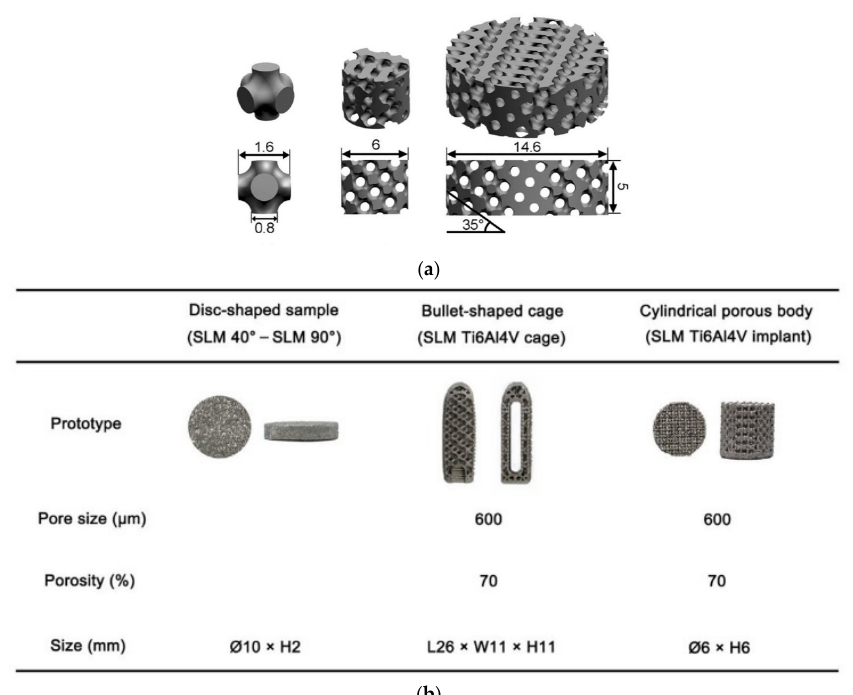
Figure 5. ( a ) CAD models of scaffold manufacturing, all measurements are in millimeters. Re- printed with permission from ref. [77]. 2021, Springer Nature. ( b ) Different SLM-fabricated sam- ples along with their parameters. Reprinted with permission from ref. [78]. 2022, Springer Nature.